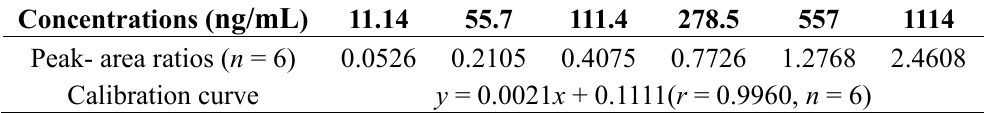
Table 3. Calibration curve of TA-III.